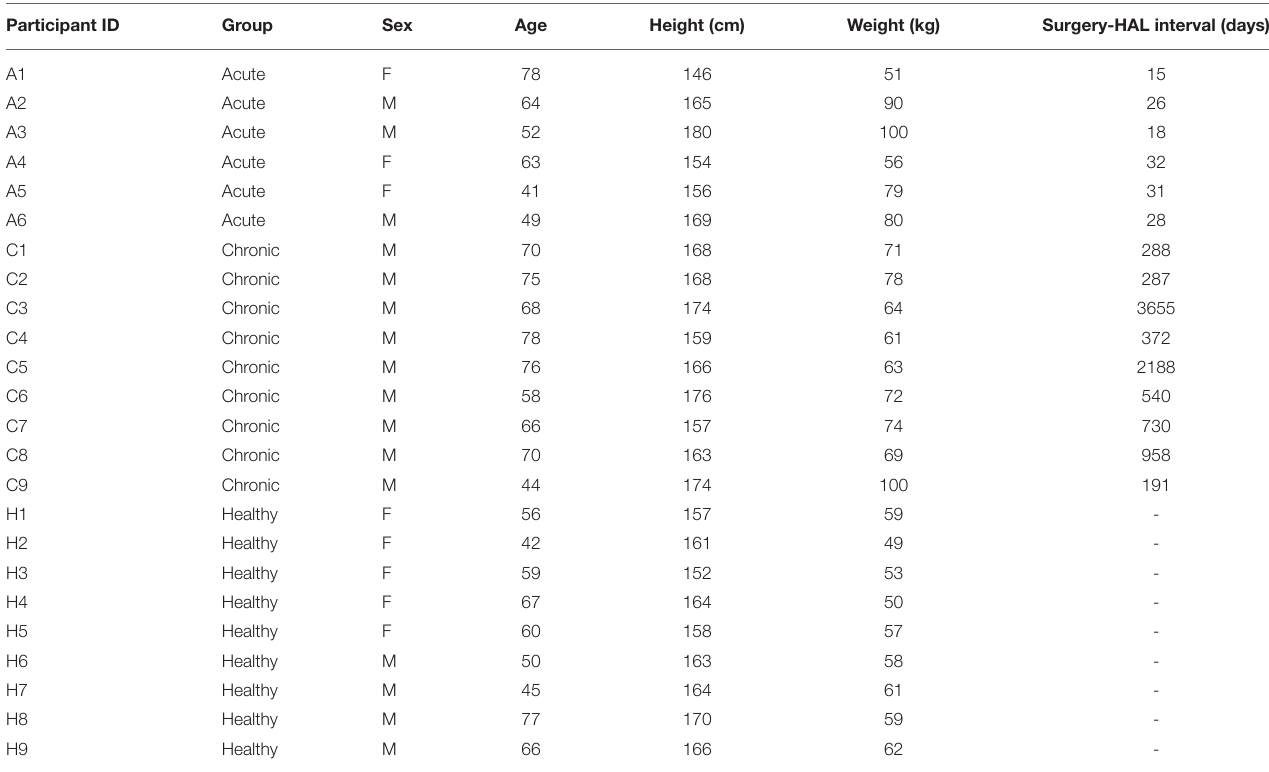
TABLE 1 | Subject characteristics. Participant